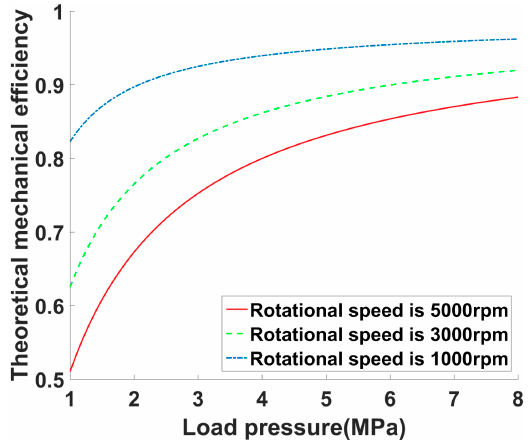
Figure 15. Theoretical mechanical e ffi ciency under di ff erent load pressures at 5000 rpm.